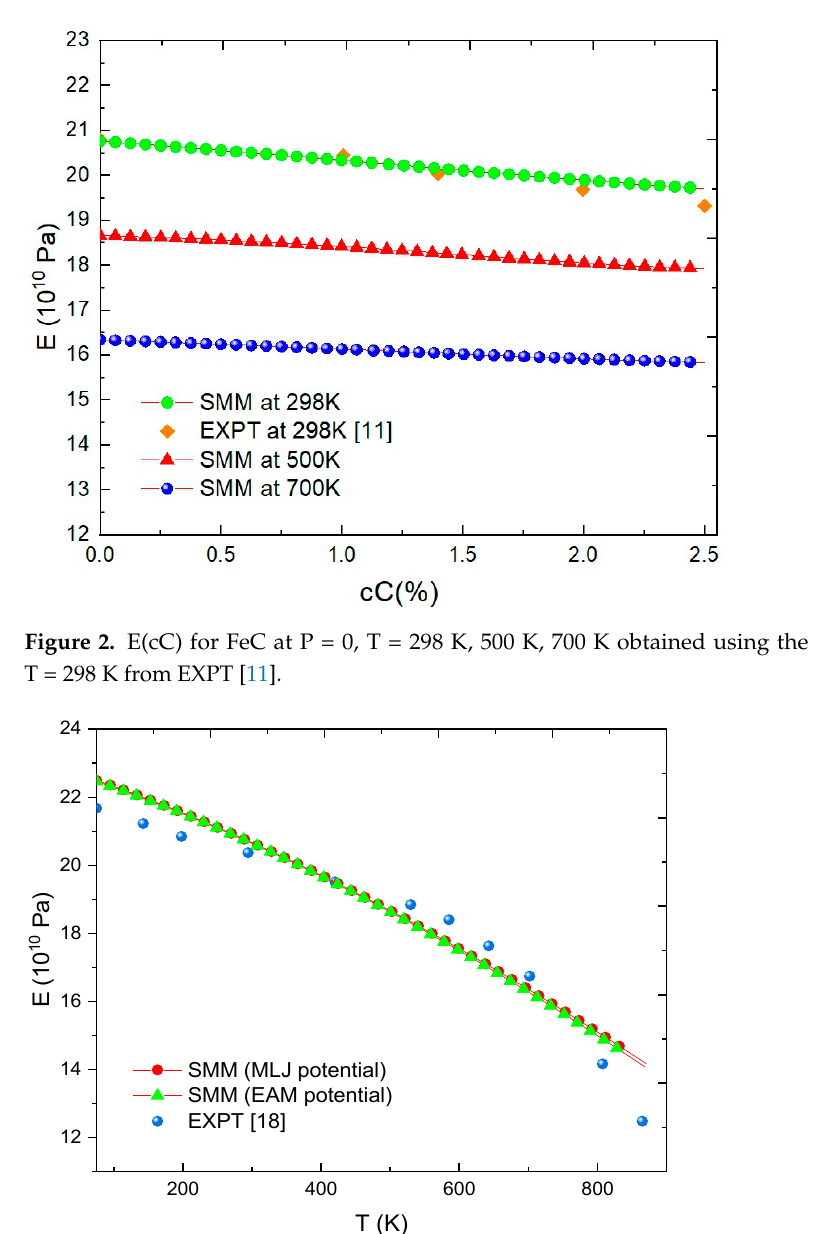
T (K) Figure 4. E(T) at P = 0 calculated by SMM with MLJ potential, SMM with EAM potential [47] and from EXPT [18] with FeC 0.4% alloy.